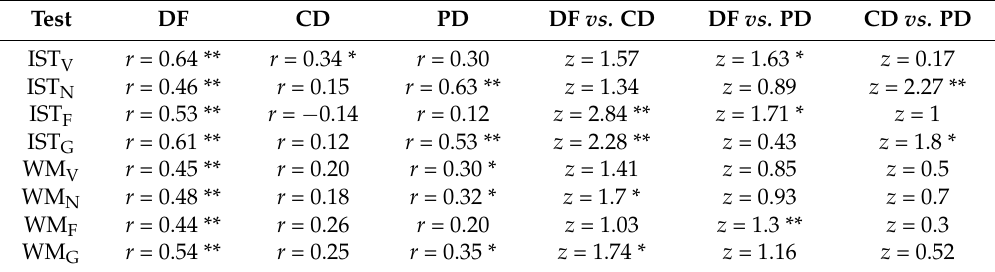
Table 2. Correlations for intelligence and working memory capacity with matrices test